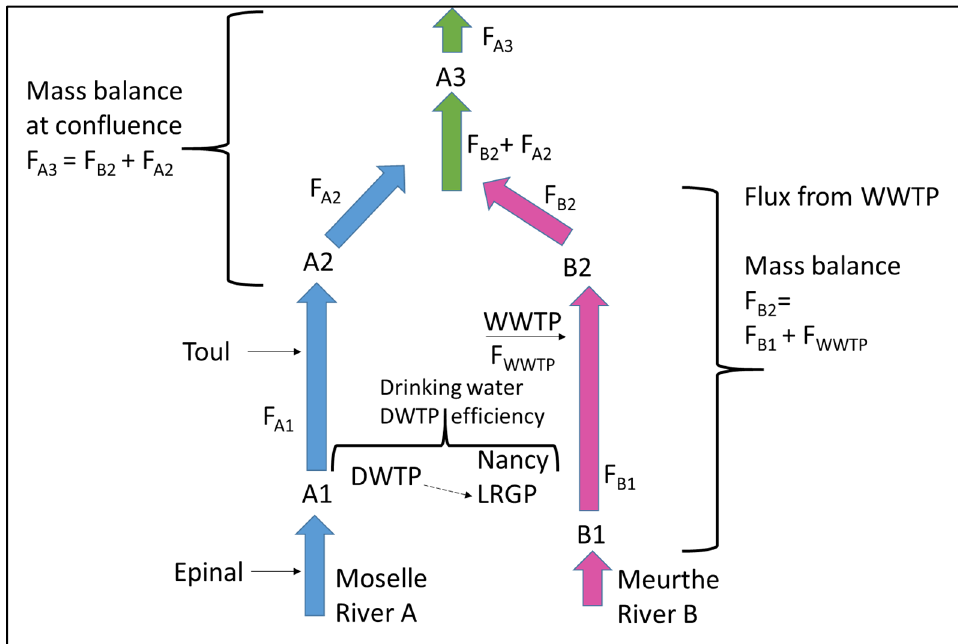
Figure 2. Schematic representation of the rivers and sampling sites with the corresponding mass flux of micropollutants (F). The zones where the mass balance is conducted are indicated by brack- ets.